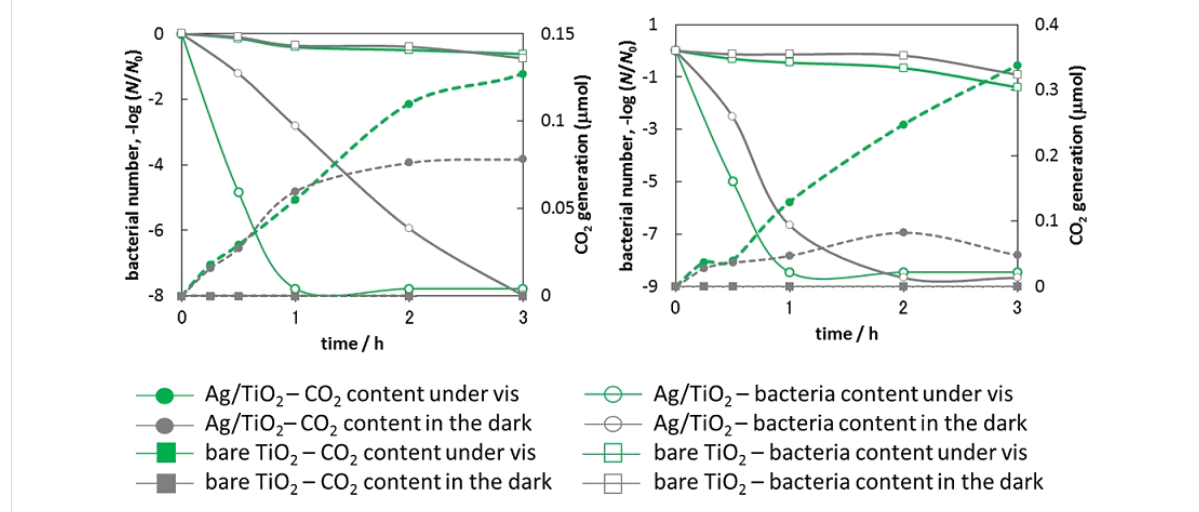
Figure 6: Number of E. coli bacteria (closed symbols) and evolution of CO 2 (open symbols) during inactivation of bacterial cells in the dark (grey symbols) and under vis irradiation ( λ > 420 nm; green symbols) on bare (squares) and modified titania (circles): (left) TiO 2 (ST01) and Ag/TiO 2 (ST01), (right) TiO 2 (FP6) and Ag/TiO 2